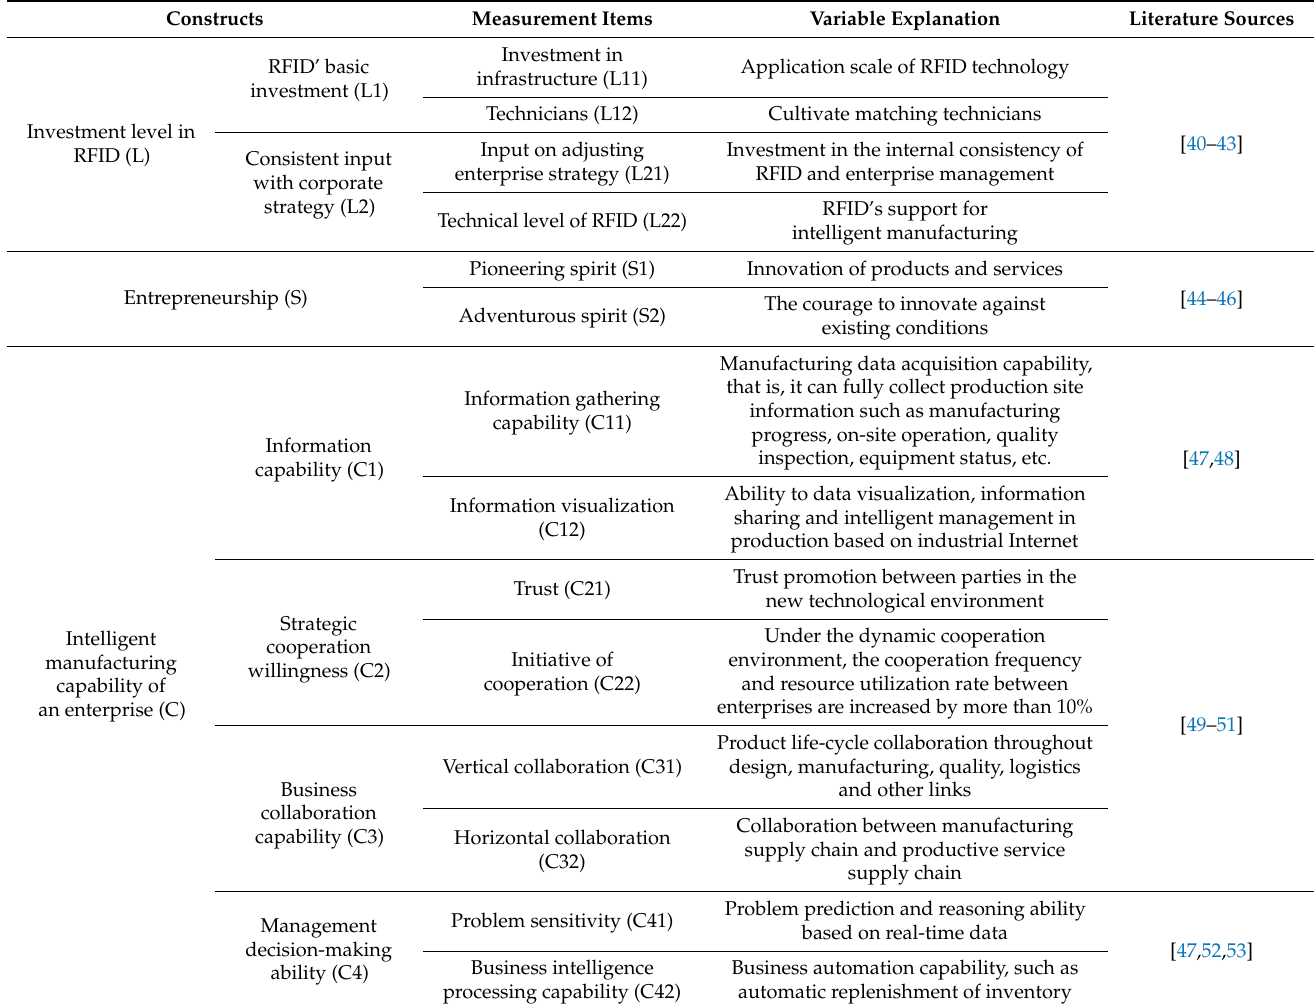
Table 1. Constructs (Latent Variables) and Measurement